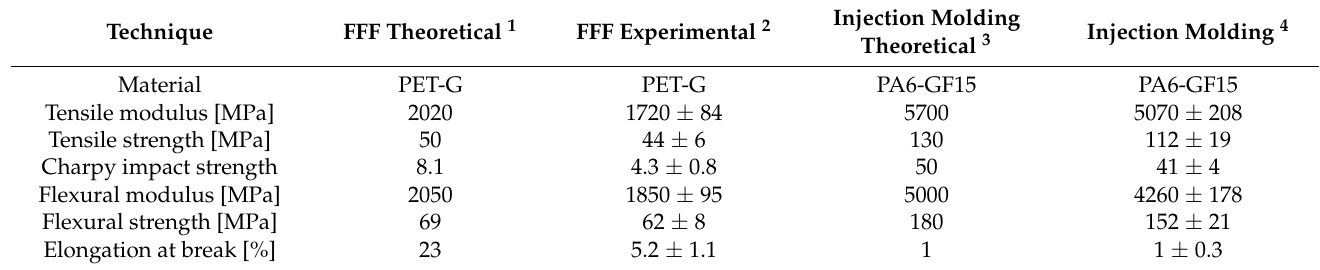
Table 3. Data for mechanical properties comparison of the objects prepared by FFF and injection molding.